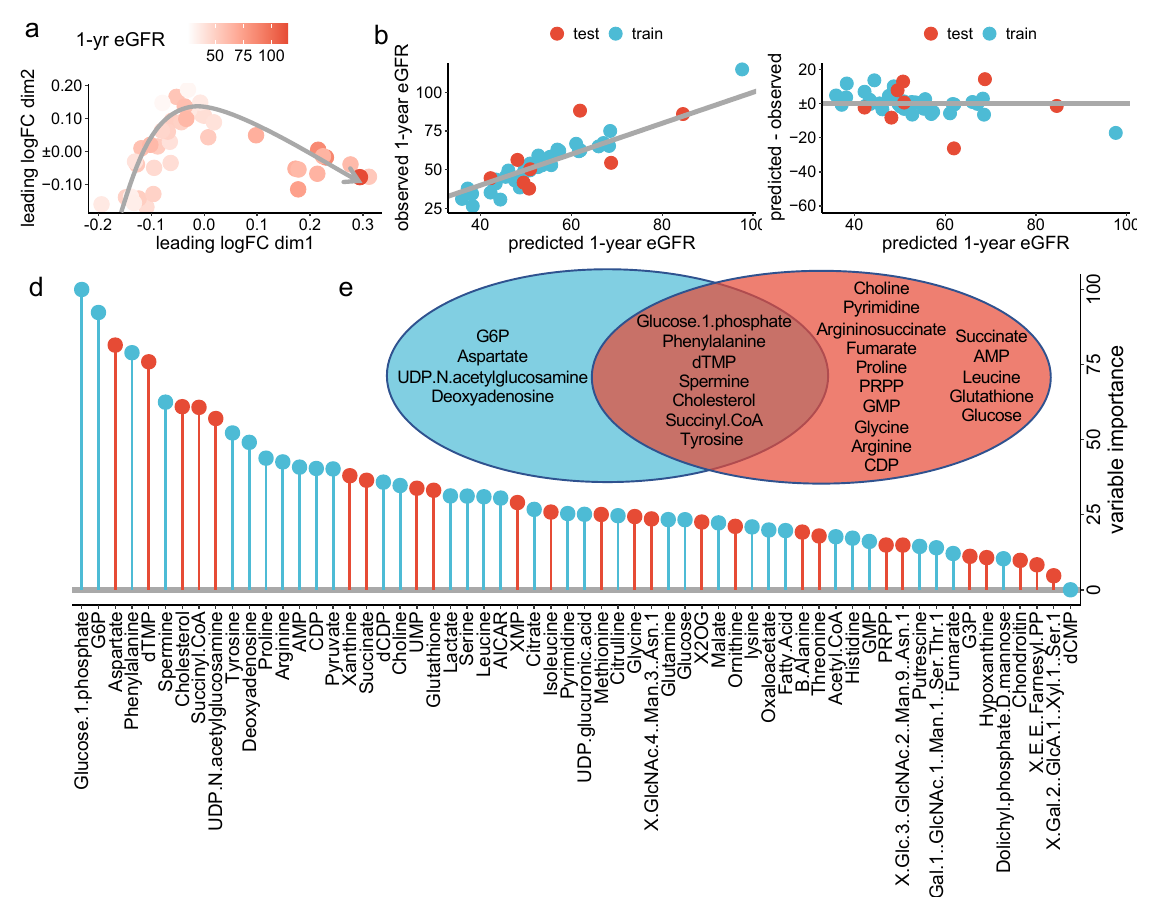
Figure 3. ML-based prediction of the one-year eGFR: ( a ) Multidimensional reduction plot showing the similarity of samples and colored by one-year eGFR, ( b ) scatter plot showing the observed ( y -axis) predicted ( x -axis) one-year eGFR, in the test (red) and training (blue) datasets. The grey line highlights the perfect relation, ( c ) Scatter plot showing the residuals for each predicted value, in the test (red)